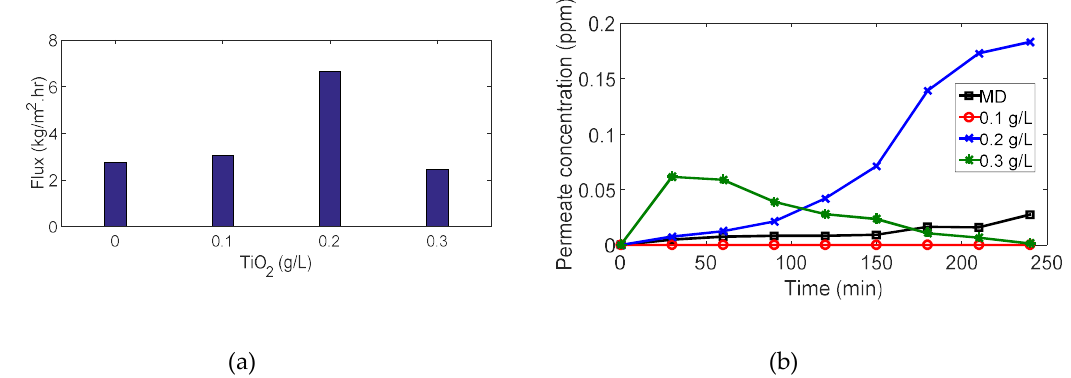
Figure 13. Results for 11 ppm MB experiments: ( a ) flux vs. amount of TiO 2 ; ( b ) permeate concentration vs. time.